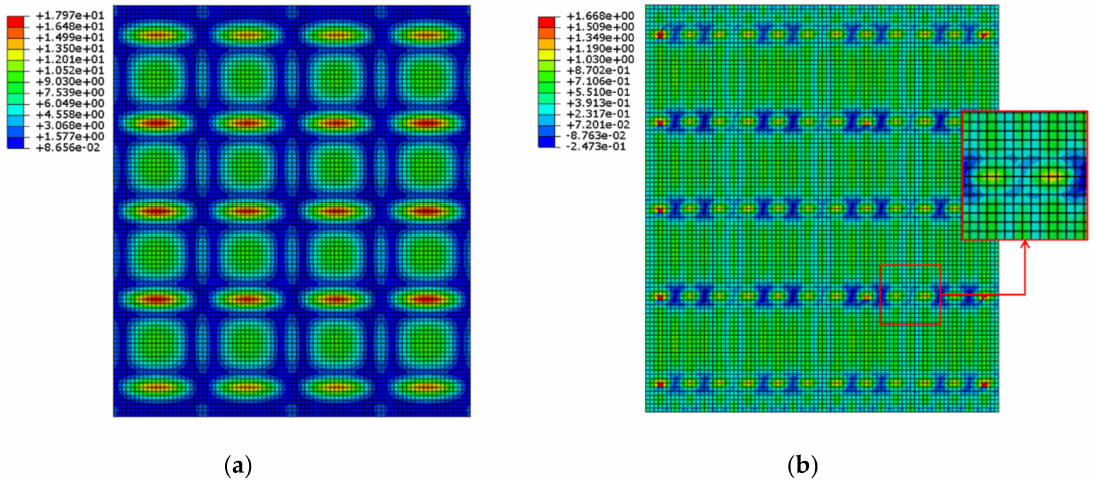
Figure 16. Tensile stress on the plate of the ship block by presence or absence of a stiffener. ( a ) Tensile stress without stiffener; ( b ) Tensile stress with